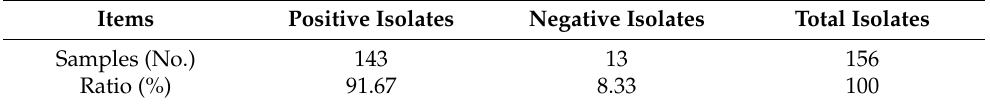
Table 2. Isolation of 156 clinical mastitis milk samples.